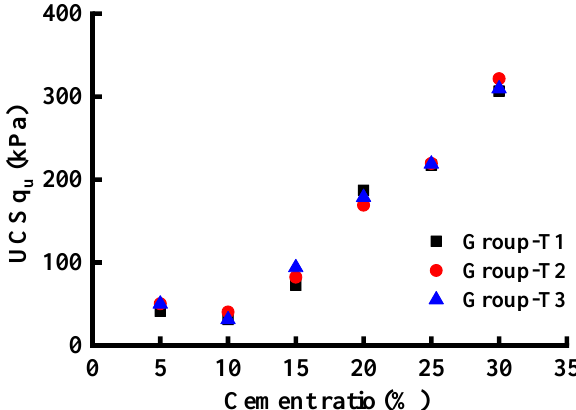
Figure 10. Summary of results of the unconfined compression tests.